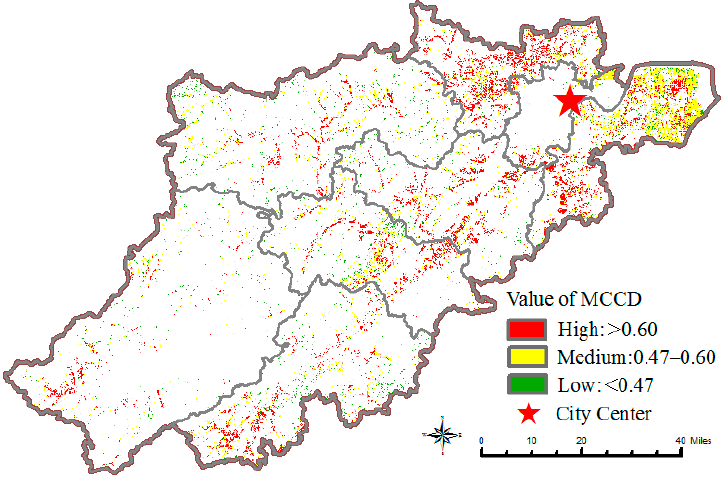
Figure 6. Spatial patterns of the multi-functional coupling and coordination degrees of farmland.